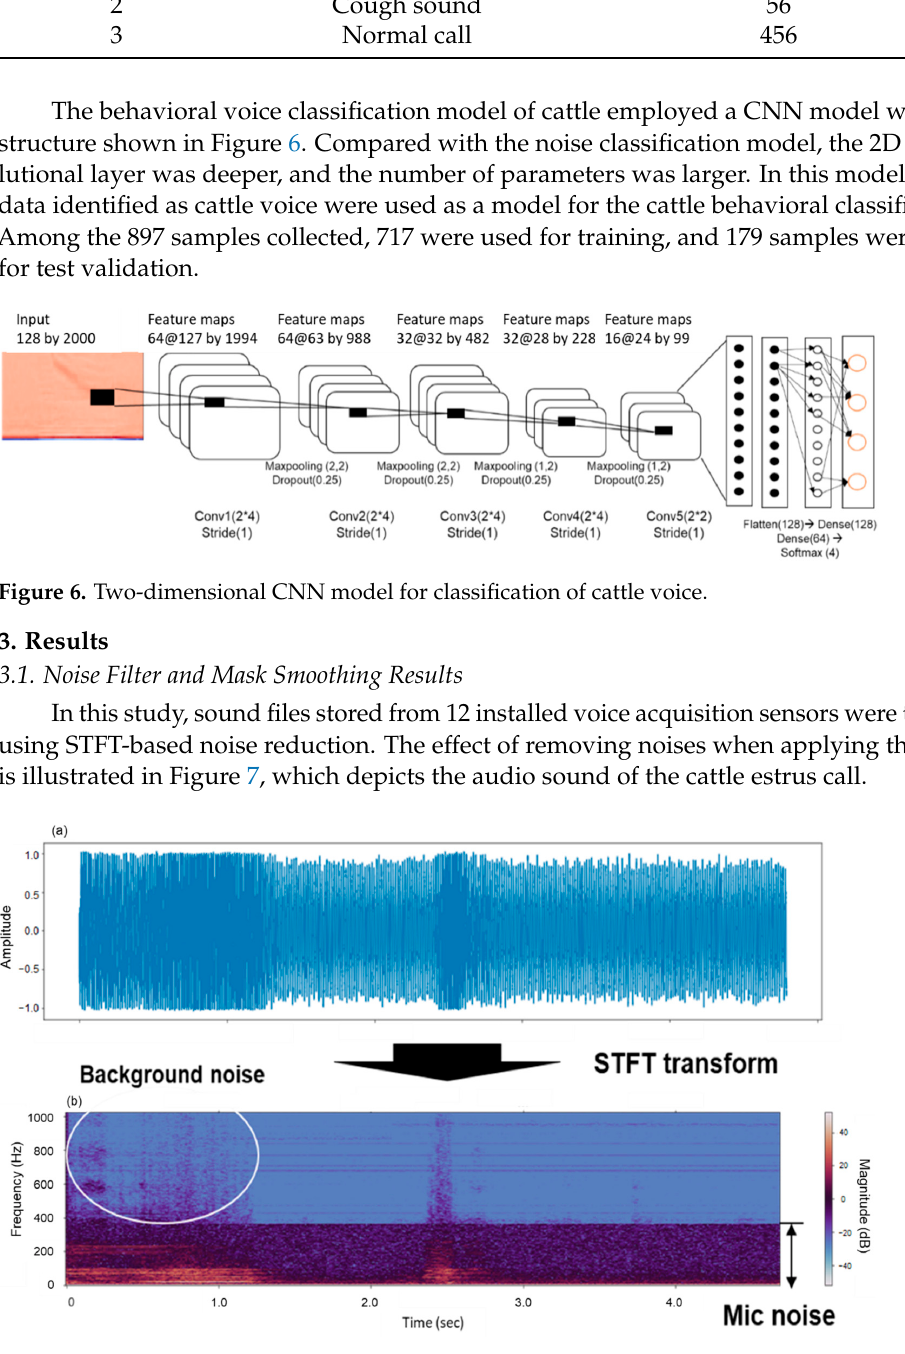
Figure 7. Two-dimensional source of cattle estrus call voice data (a) and the conversion to short- time Fourier transform (STFT) area (b). Fourier transform (STFT) area ( b